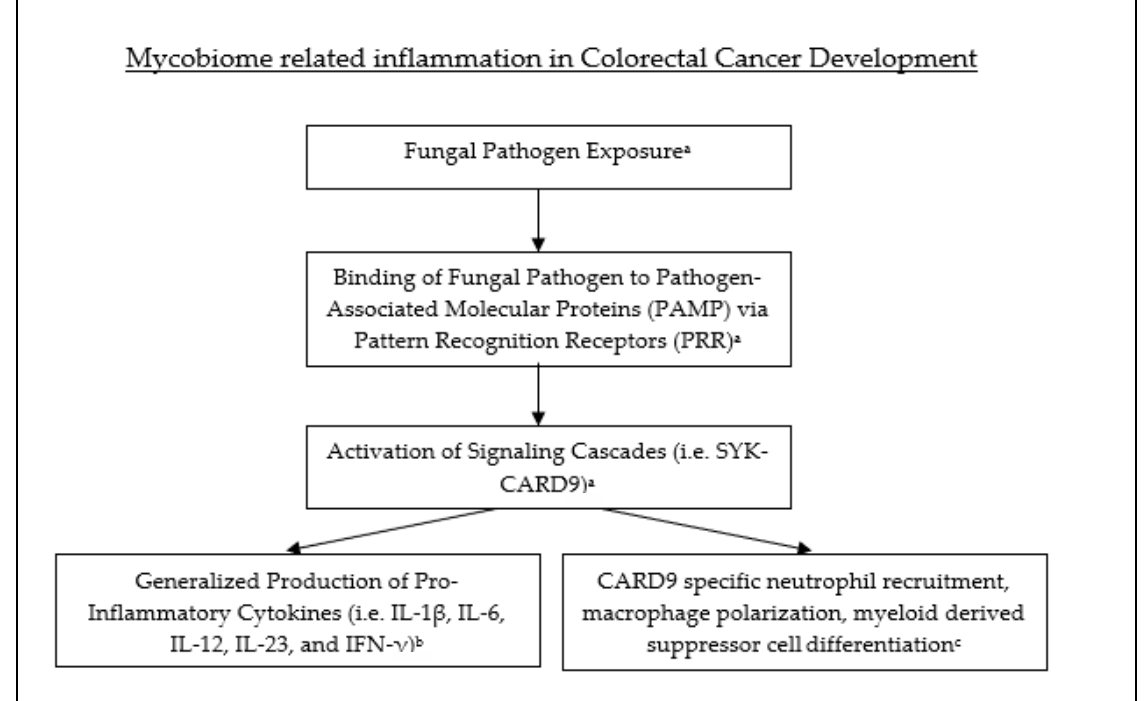
Figure 3. Fungal pathogen exposure leads to binding with PAMP, subsequent activation of signaling cascades and production of inflammatory cytokines as well as recruitment and activation of inflammatory cells. a -Hatinguias et al. b -Malik et al. c -Bertin et